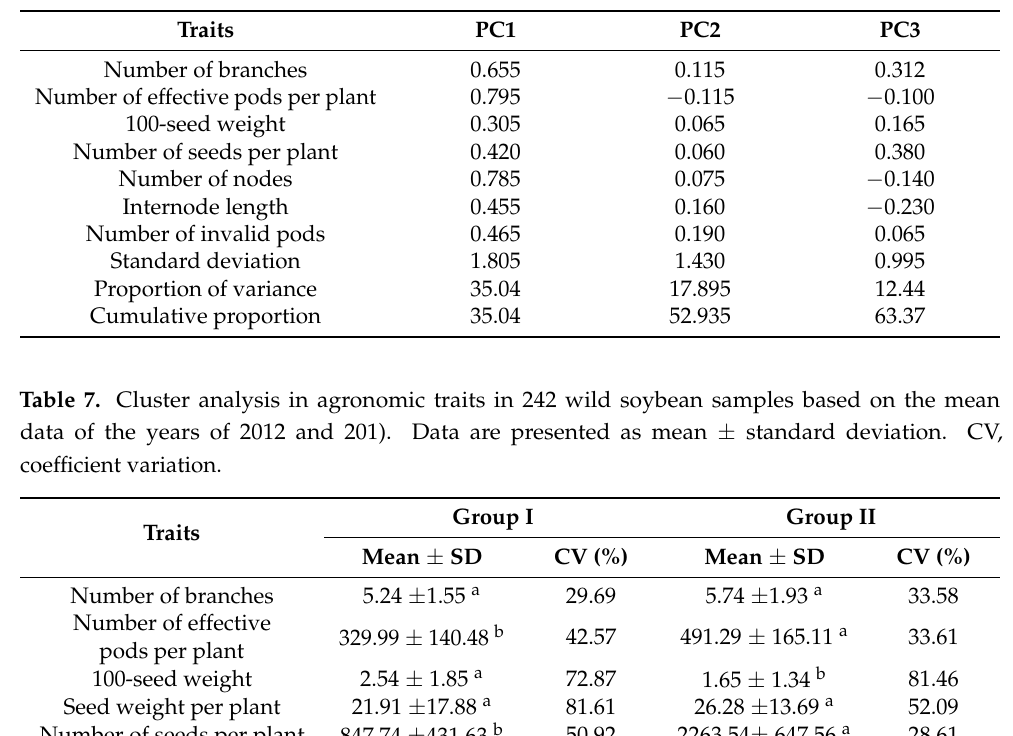
Table 6. Factor loadings (principle component one (PC1), PC2, and PC3) of the principal component analysis, based on the agronomic traits in 242 wild soybean samples, based on the mean data in the years of 2012 and 2013.